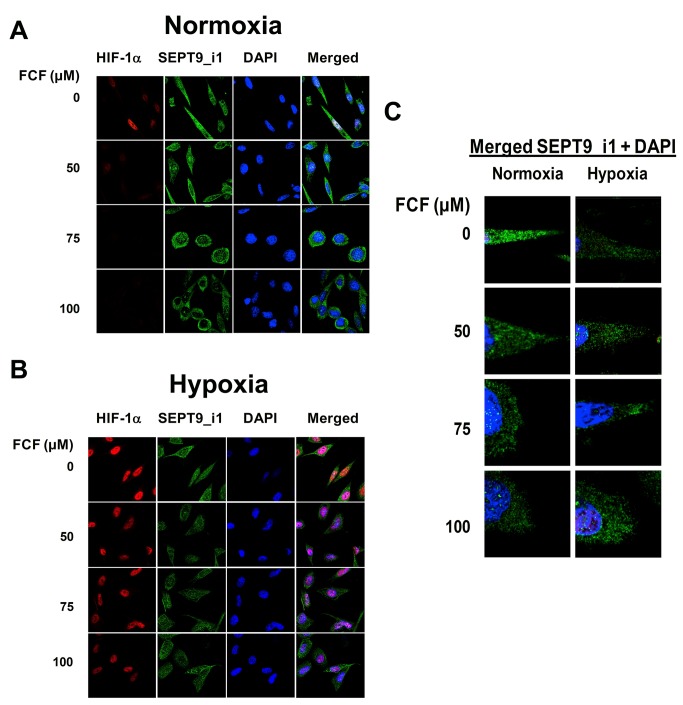
FCF alters SEPT9_i1 filamentous organization and localization.PC-3 cells were treated with FCF for 2 h and grown in normoxia (A) or hypoxia (B) for 4 additional h. They were fixed and processed for immunofluorescent labeling with anti-HIF-1α (red), anti-SEPT9_i1 (green) and DAPI (blue). Staining was analyzed by confocal laser-scanning microscope (magnification x63). (C) Representative cells from each treatment condition presented in (A) were further enlarged (zoom x2) for better visualization of SEPT9_i1 filaments (green).